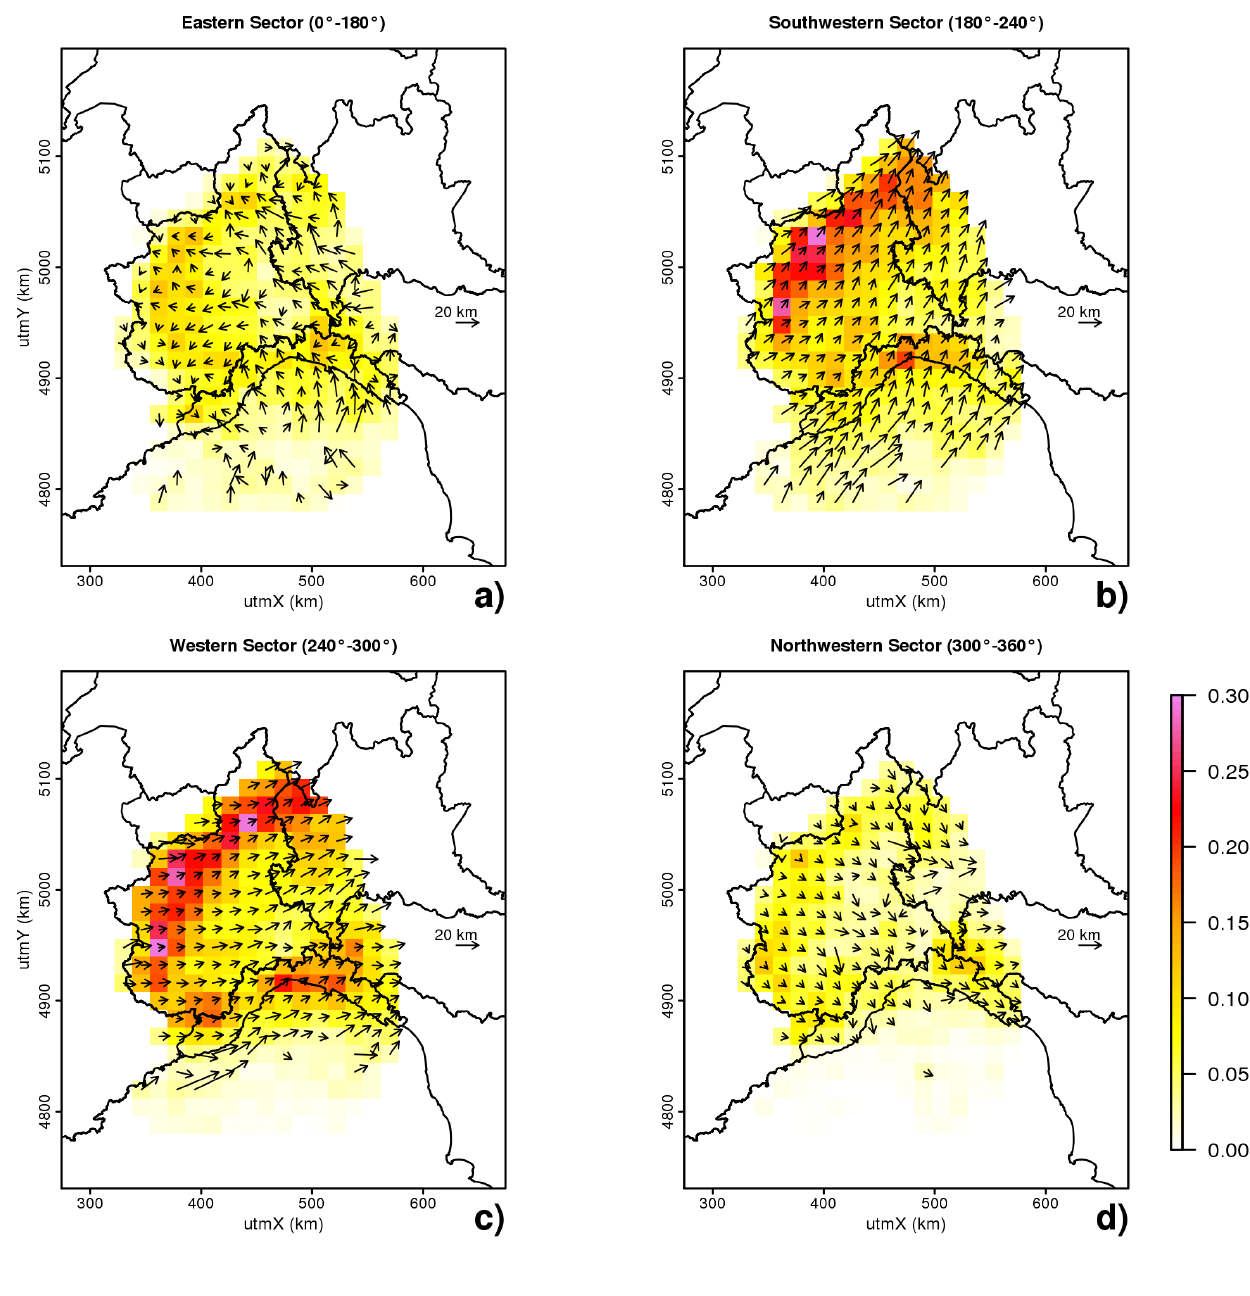
Figure 14. Spatial distribution of mean IDs density (colors) and track directions (vectors) over North-Western Italy in function of the wind mean direction in the layer 500–700 hPa. Arrow lengths represent the mean distance travelled. Averages have been evaluated for each 16 km grid box. ( a ) Eastern sector (directions from 0° to 180°); ( b ) South-South-Western sector (180°–240°); ( c ) Western sector (240°–300°); ( d ) North-North-Western sector